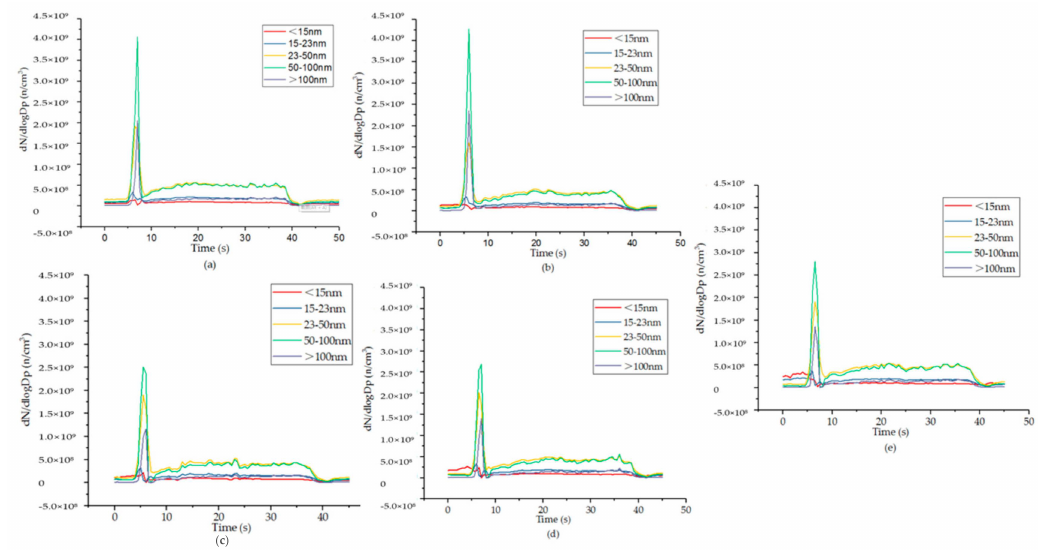
Figure 3. Effects of different amounts of post-injection on PM number size distribution vs. Time: ( a ) Original; ( b ) 1 mg; ( c ) 2 mg; ( d ) 3 mg; and ( e ) 4 mg